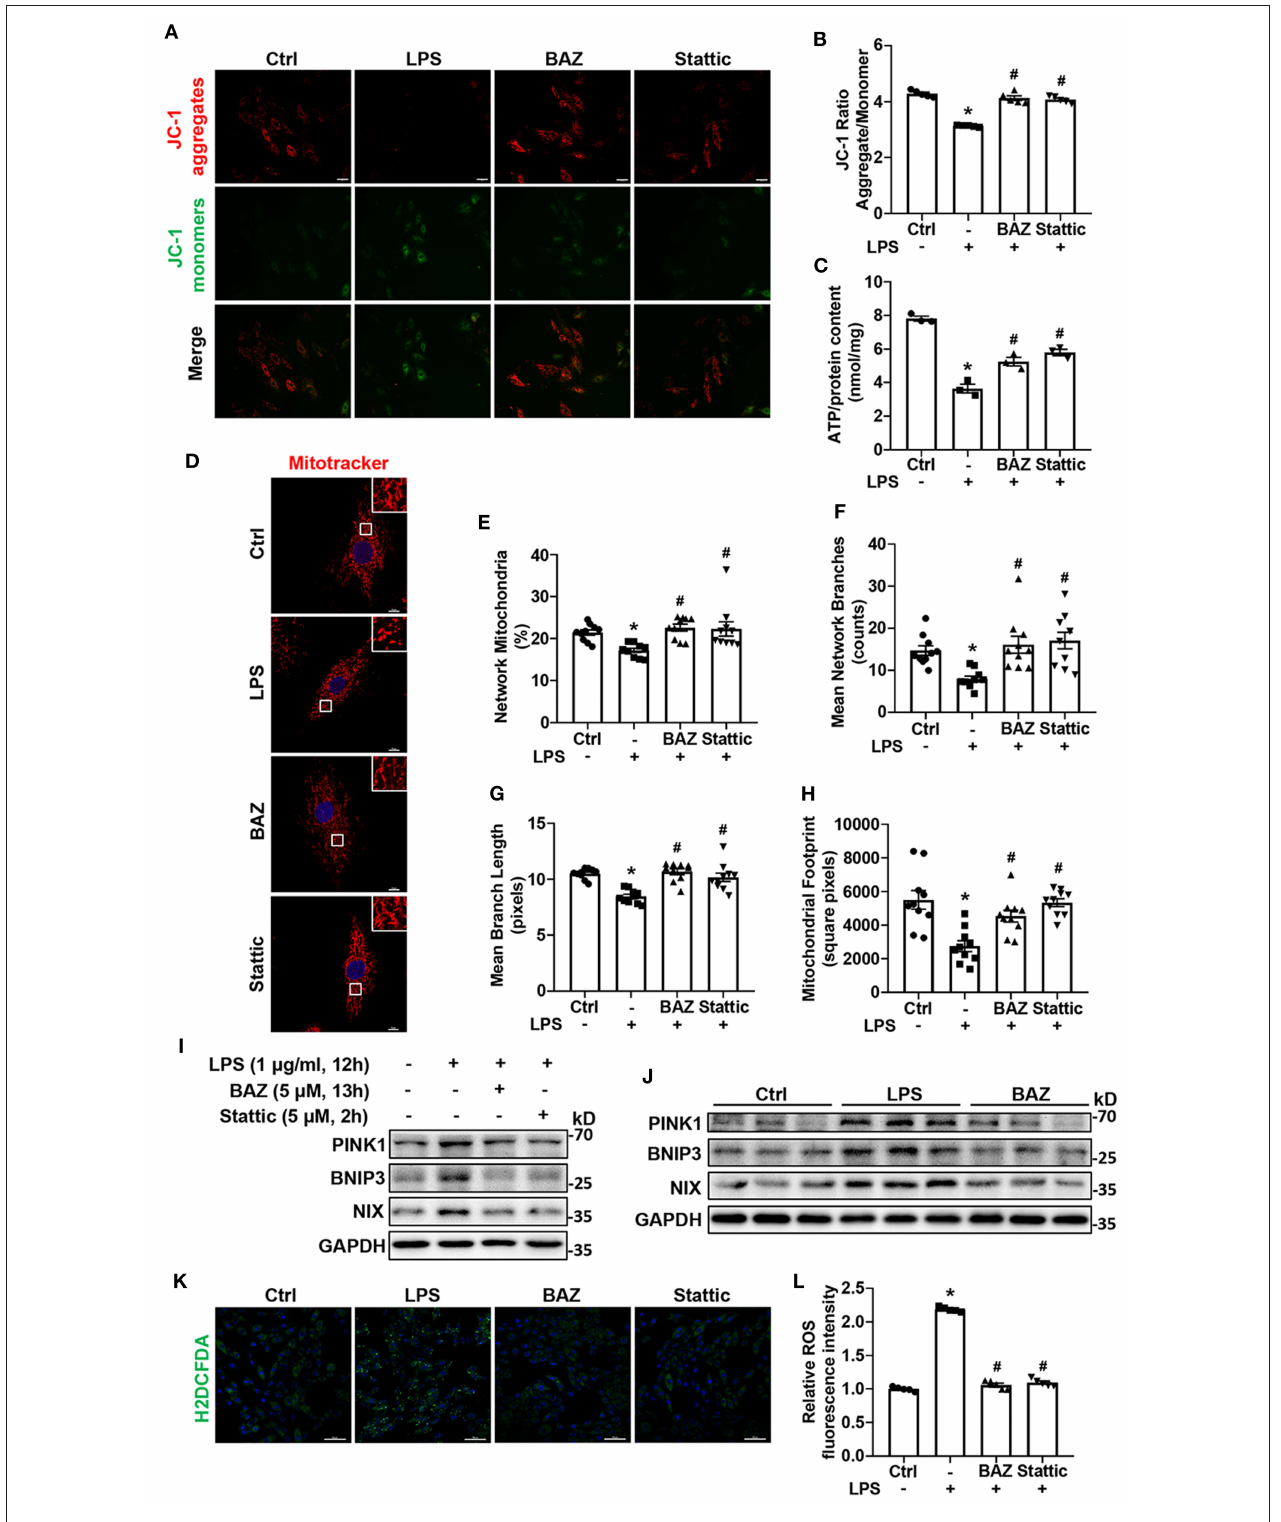
FIGURE 6 | IL-6/STAT3 inhibitor alleviated LPS-challenged mitochondrial dysfunction and ROS production in cardiomyocytes. H9c2 cells were treated as described in Figure 5 . (A) JC-1 staining was used to detect the mitochondrial membrane potential. Representative fluorescence images of JC-1 aggregate (red) and